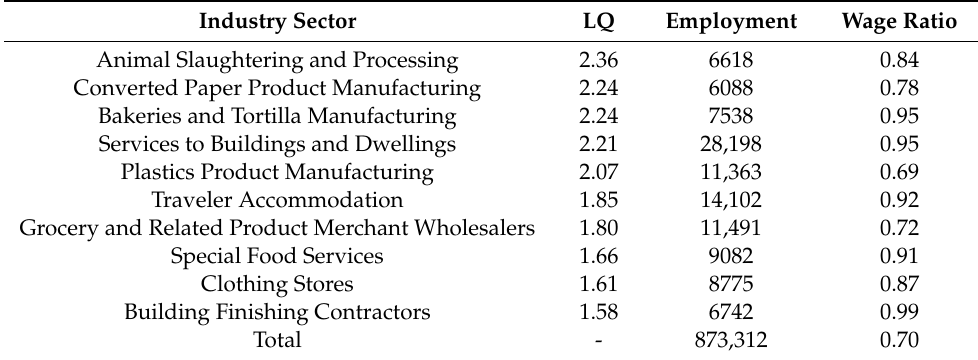
Table 4. Relative Earnings for Latinx in Top 10 Industries with High Concentration of Latinx.